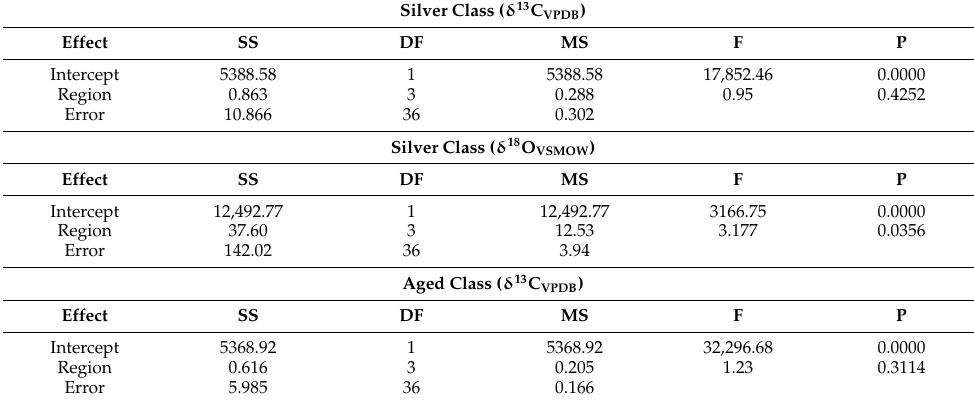
Figure 3. Statistical analysis of the values of δ 13 C VPDB and δ 18 O VSMOW , for tequila 100% agave silver class ( a , b ), aged class ( c , d ), and extra-aged class ( e , f ). class ( a , b ), aged class ( c , d ), and extra-aged class ( e , f ). Table 2. One-way analysis of variance for δ 13 C VPDB and δ 18 O VSMOW in different classes of tequila 100% agave (silver, aged, and extra-aged class) grouping the data by region. SS: Sum-of-squares, DF: Degrees of freedom, MS: Mean squares, F: F-value = MS intercept /MS error , P: p